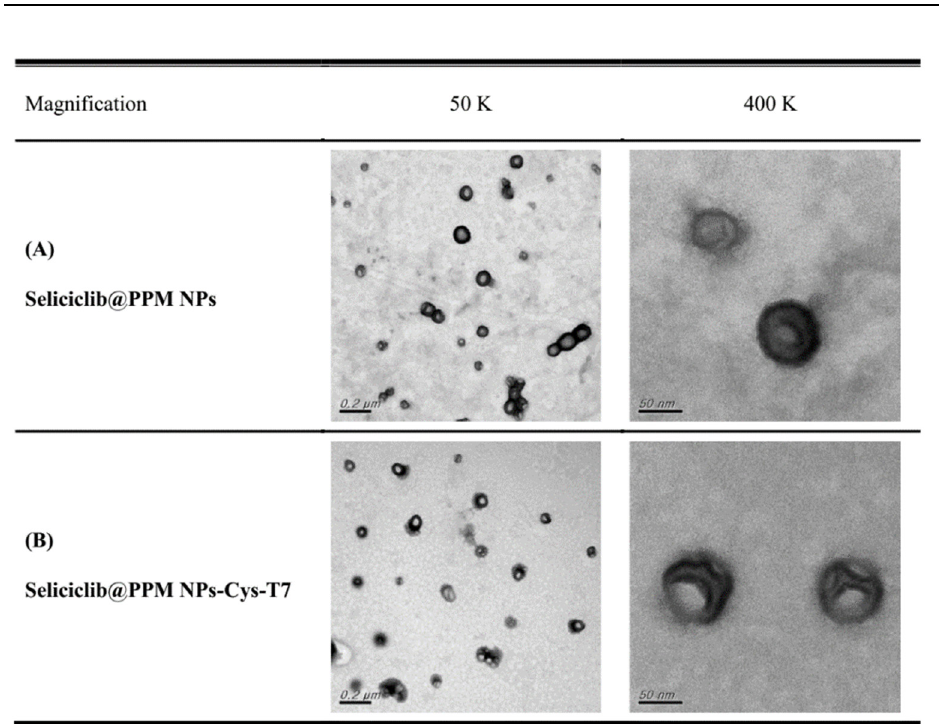
Figure 2. Transmission electron microscope (TEM) images of ( A ) seliciclib@PPM NPs and ( B ) seliciclib@PPM NPs-Cys-T7 with magnification 50 K (scale bar: 200 nm) and 400 K (scale bar: 50 nm).